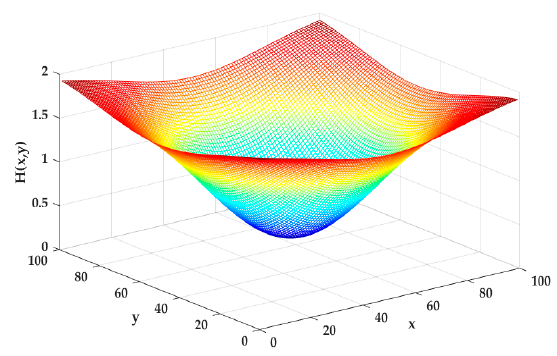
Figure 3. 3-D mesh of the high-pass filter.